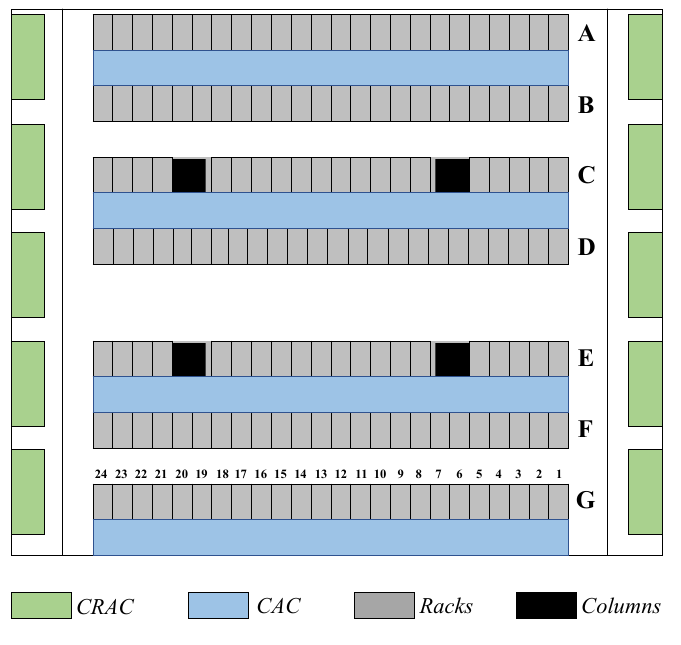
Figure 3. Data center layout.